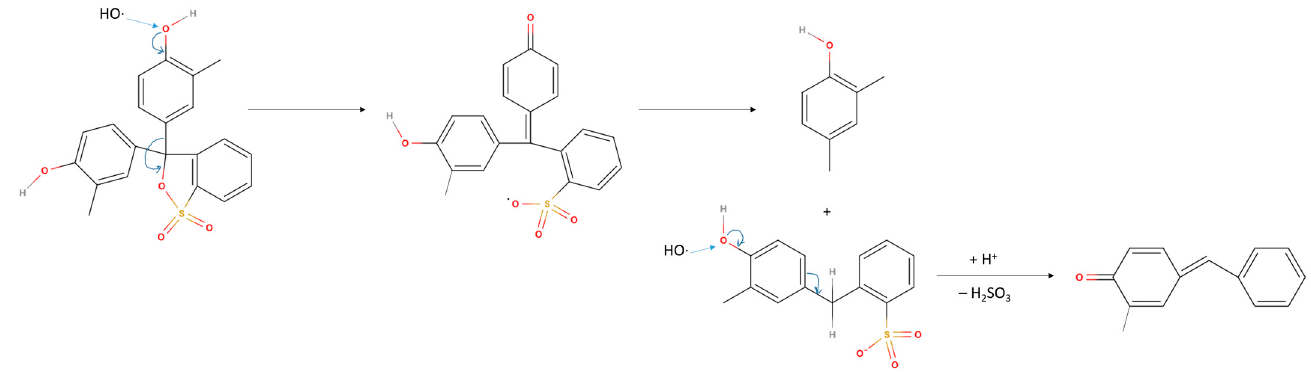
Figure 9. Probable degradation mechanism of cresol red.